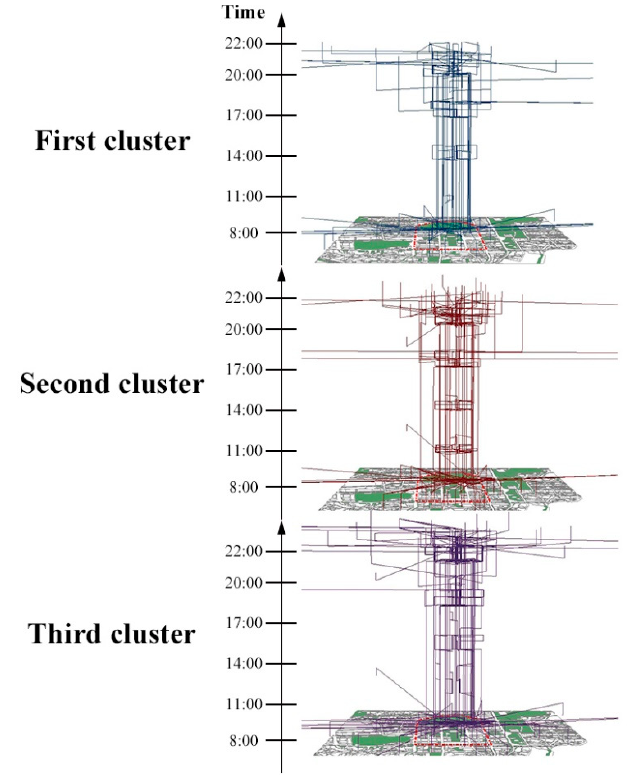
Figure 7. Spatiotemporal paths for green space use of different clusters.